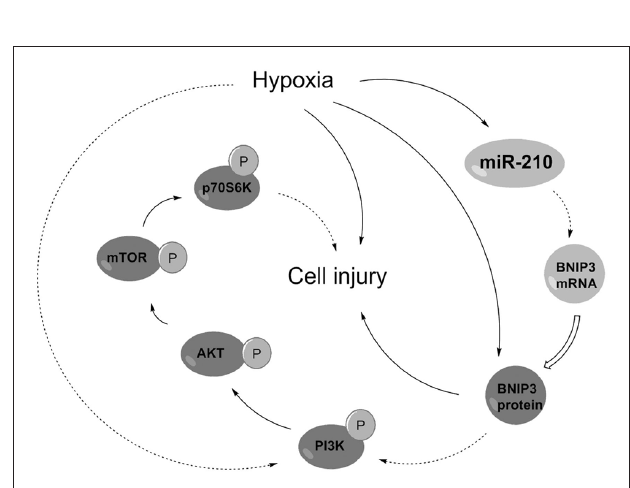
FIGURE 8 | Regulatory circuit of the microRNA (miR)-210-associated modulation in PC-12 cells under hypoxia. Solid arrows indicated positive regulation but dotted indicated negative regulation. BNIP3, Bcl-2 adenovirus E1B 19 kDa-interacting protein 3; PI3K, phosphatidylinositol 3-kinase; mTOR, mammalian target of